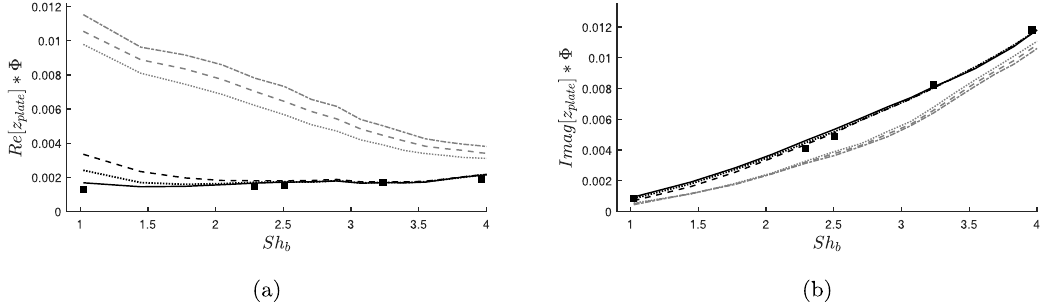
Figure 7. Comparison of the a) slit resistance and b) slit inertance for long slits compared to 2D model ( & ) as function of Shear number for several amplitudes at the reference microphone. Low amplitudes: ( –– ) 0.4 Pa, (. . . .) 1 Pa, (- - -) 2 Pa. High amplitudes: ( –– ) 17 Pa, (. . . .) 20 Pa, (- - -)23